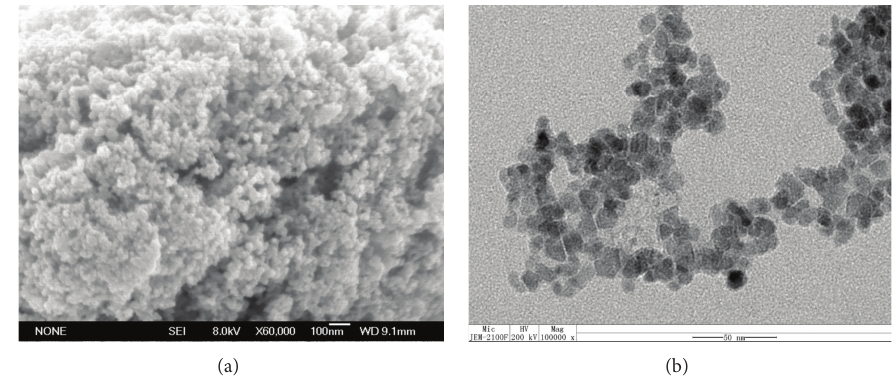
Figure 2: (a) SEM image and (b) TEM micrograph of Ni nanoparticles.